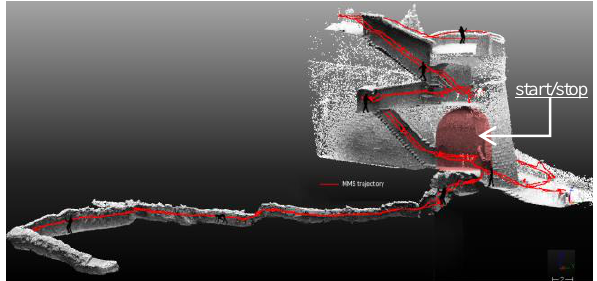
Figure 1. The three-levels tower and the underground “ nottola ” of the S. Vigilio Castel. The two main datasets and trajectories in red line and in red colour the entrance, as the area in common between the two datasets